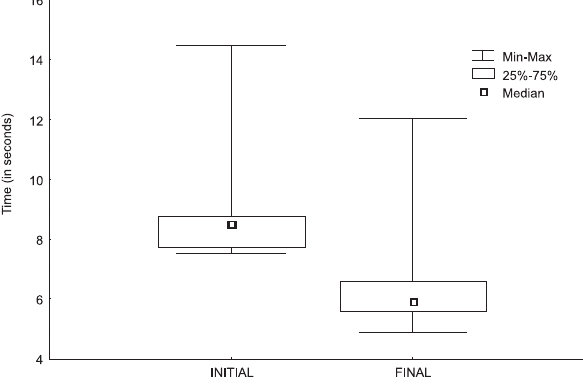
Figure 2 - Time necessary to sit-standing before and after one year of resistance training ( p =0.003)